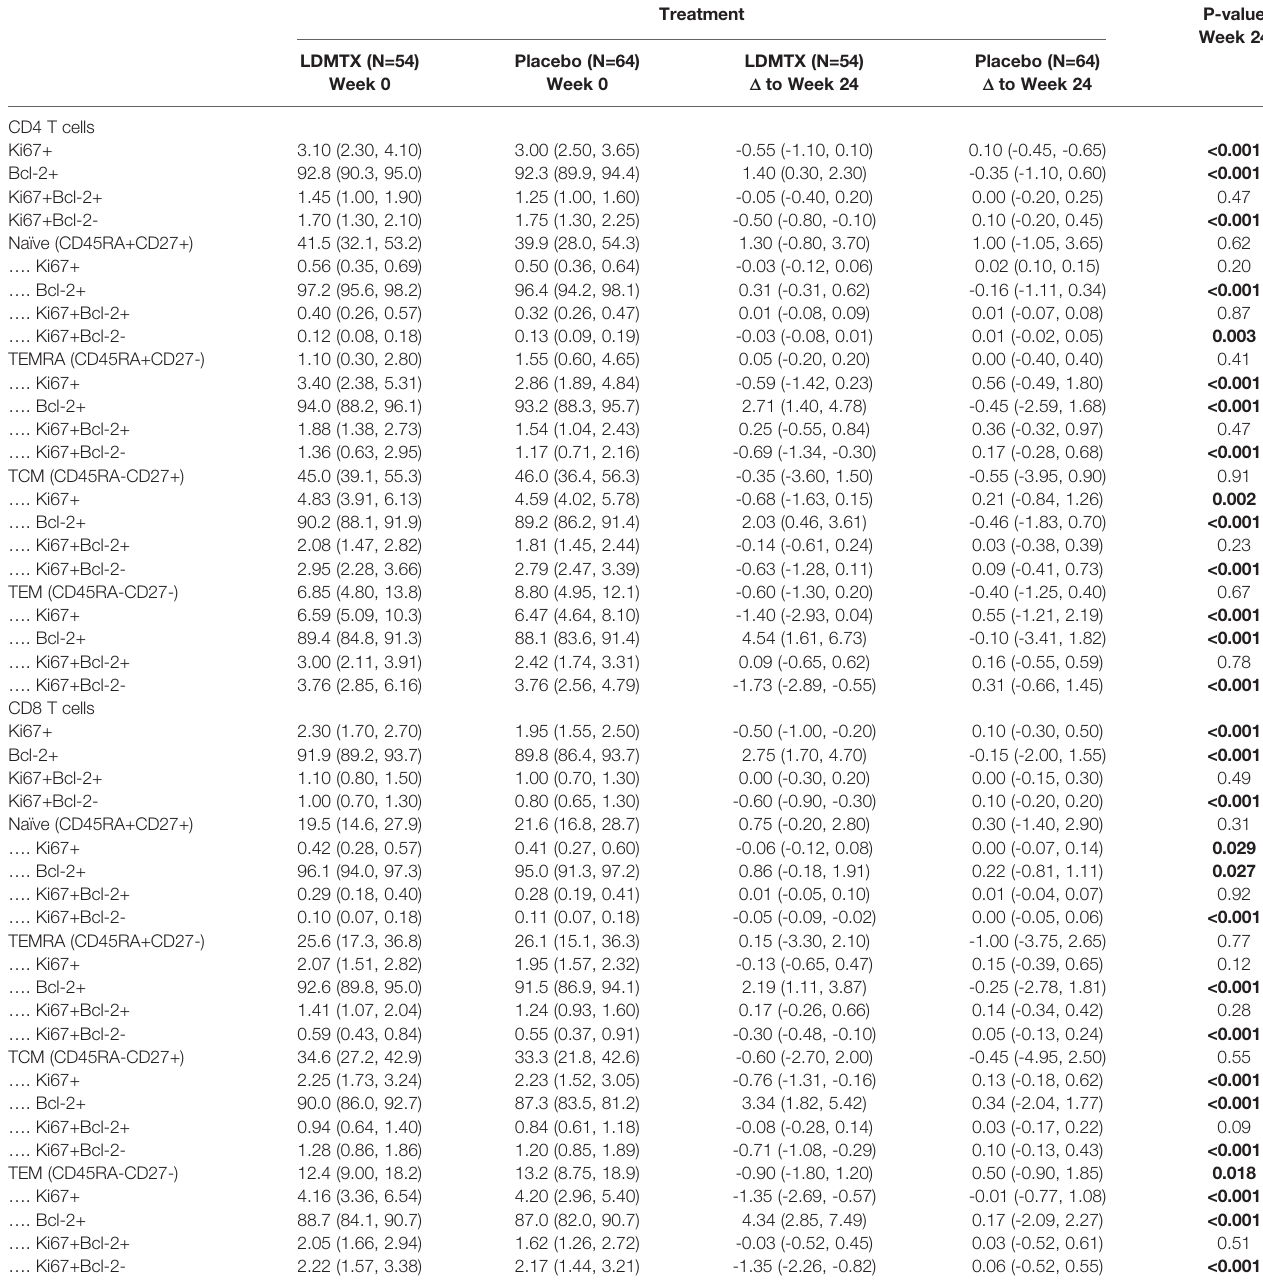
TABLE 3 | Changes from baseline in T cell subsets and Ki67 and Bcl-2 expression.